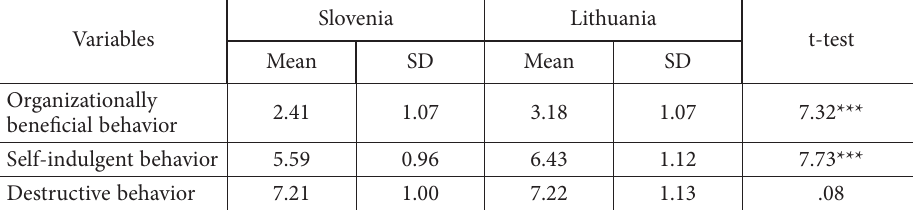
Table 3. Ethicality of behavior for advancement in the workplace in Slovenia and Lithuania (created by the authors) Variables Organizationally beneficial behavior